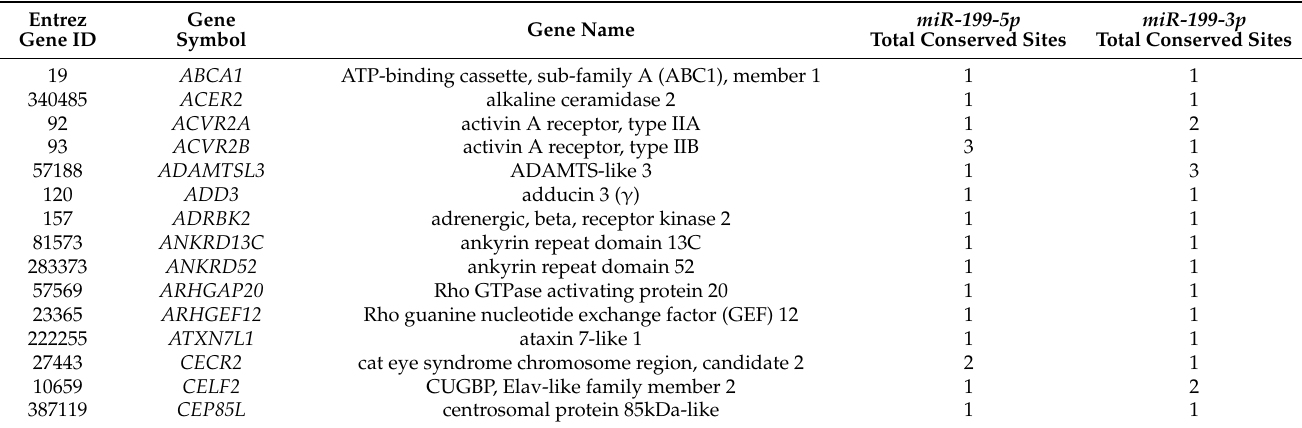
Table 1. miR-199-5p/3p common target